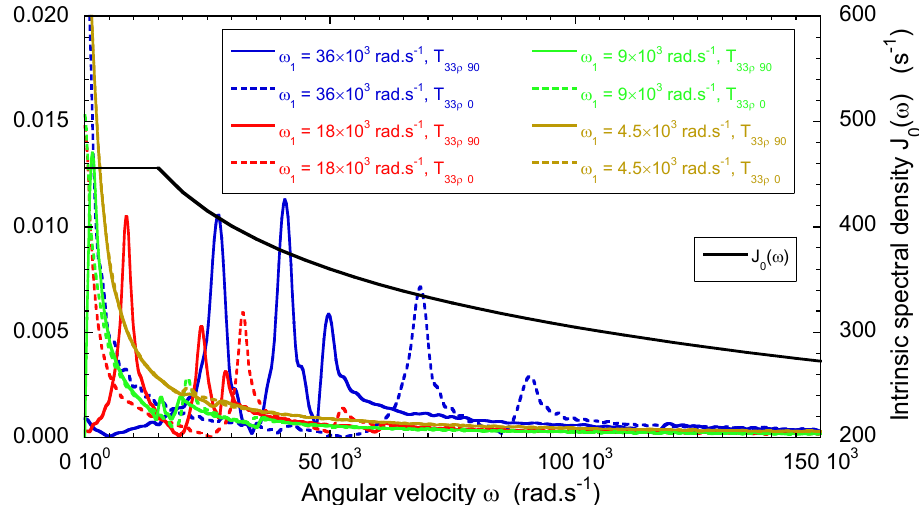
Figure 12. Illustration of the frequency domain probed by time evolution of the T 33 ( a , s ) coherences under spin-locking conditions, leading to the dispersion curve of the 7 Li NMR relaxation rate. Reprinted with permission from Ref. [41]. Copyright (2009) American Chemical